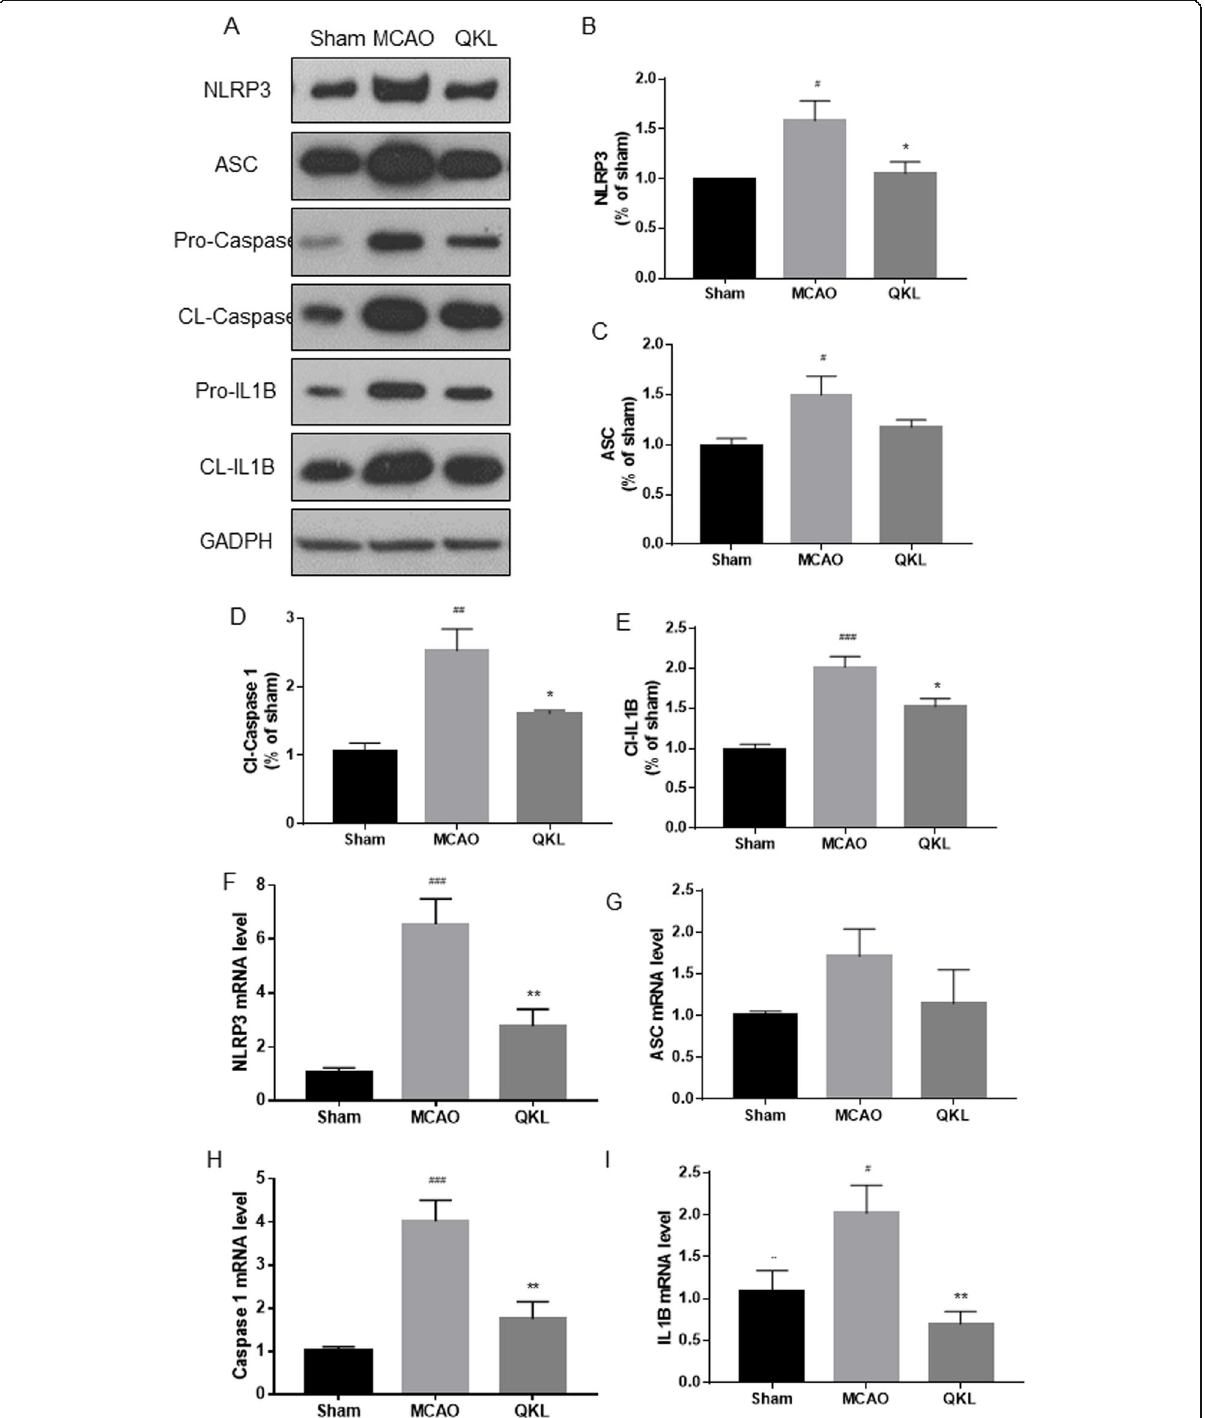
Fig. 5 QKL inhibited NLRP3 inflammasome activation post-stroke. (A) Western blot analysis of NLRP3, ASC, pro-caspase 1, cleaved-caspase 1, pro- IL-1 β , cleaved-IL-1 β and GAPDH. (B-E) Quantitative analysis of NLRP3, ASC, Cl-caspase 1 and cl-IL-1 β expression. (F-I) Quantitative polymerase chain reaction (QPCR) analysis of NLRP3, ASC, caspase 1 and IL-1 β mRNA. Data points indicate means ± SEM. Vs Sham group, # < 0.05, ## < 0.01, ### < 0.001, Vs MCAO group, * p < 0.05, ** p < 0.01. At least three independent experiments were performed for each